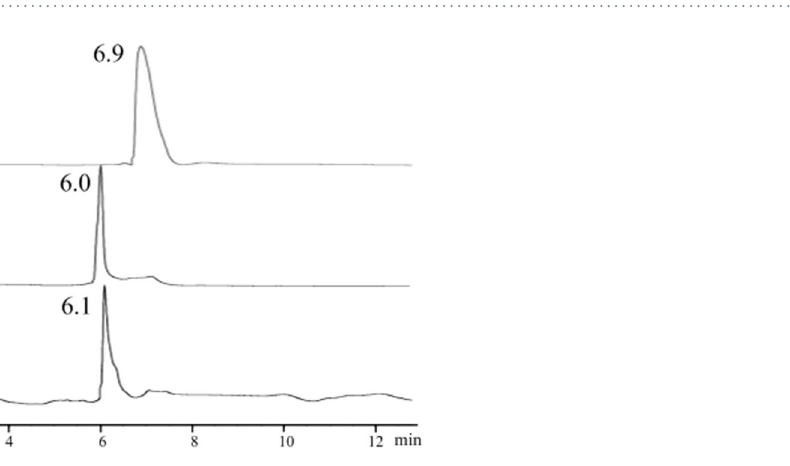
Figure 2. Synthesis of matrine derivatives 1 and 2.